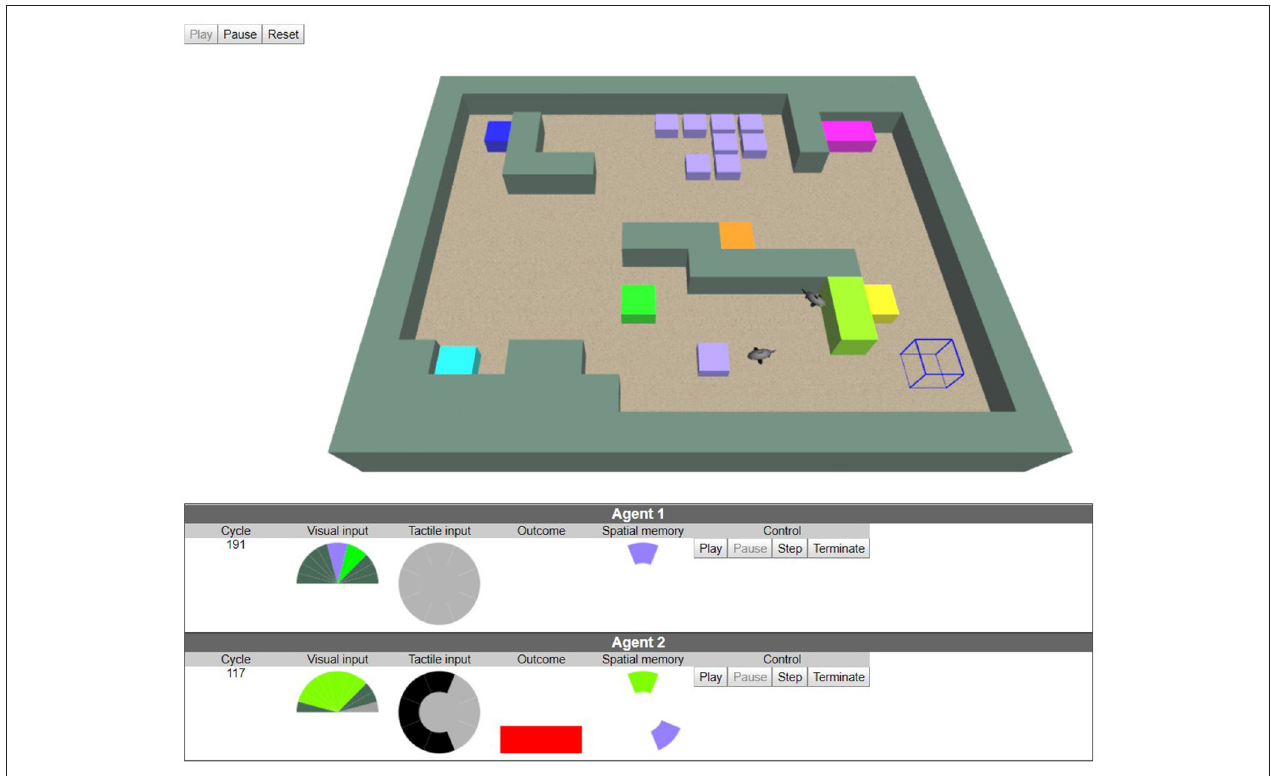
FIGURE 3 | An interactive experiment in a dynamic simulated environment (screenshot from Georgeon, 2021). (Top) two agents (sharks) interact with each other and with three kinds of objects: solid blocks (1 × 1 × 1 cubes), go-through tiles (1 × 1 × 0.5 tiles), food tiles (1 × 1 × 0.5 violet tile). Solid blocks and tiles are opaque to the agent’s visual system. The user can add and remove objects and agents in the environment through a mobile cursor (the wired cube). (Bottom) control panels of each agent: visual inputs (12 “pixels” spanning 180 ◦ ), tactile input (feeling solid blocks around the agent), outcome (bumping into a solid block, socializing by touching another agent, eating food). Egocentric spatial memory (head upward) recording phenomena in the surrounding of the agent. Agent 2’s spatial memory shows that Agent 2 remembers the presence of a violet tile at its rear right even though the tile exited the agent’s visual